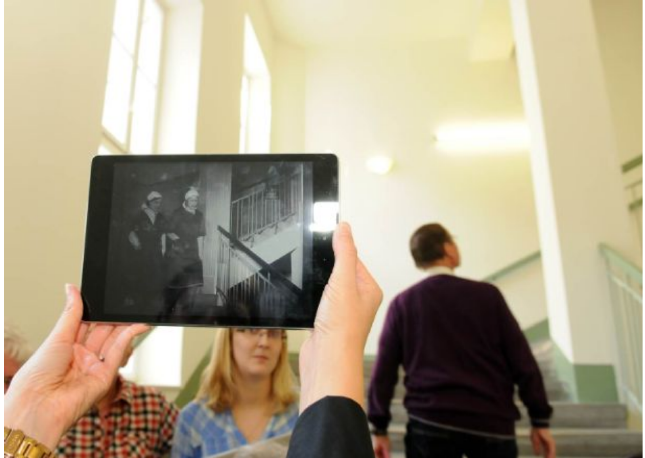
Figure 4. Guided tour with the augmented reality app “time travel tobacco